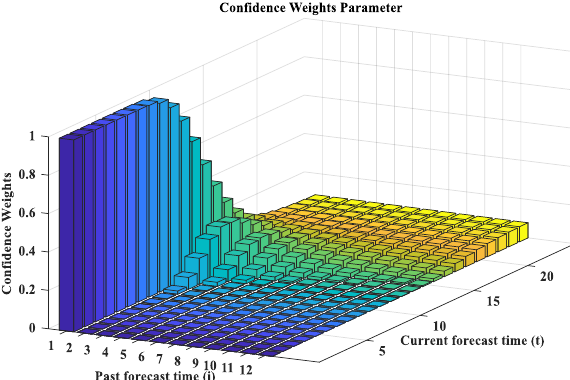
Figure 2. Confidence weight parameters for the past 12-h forecast load.